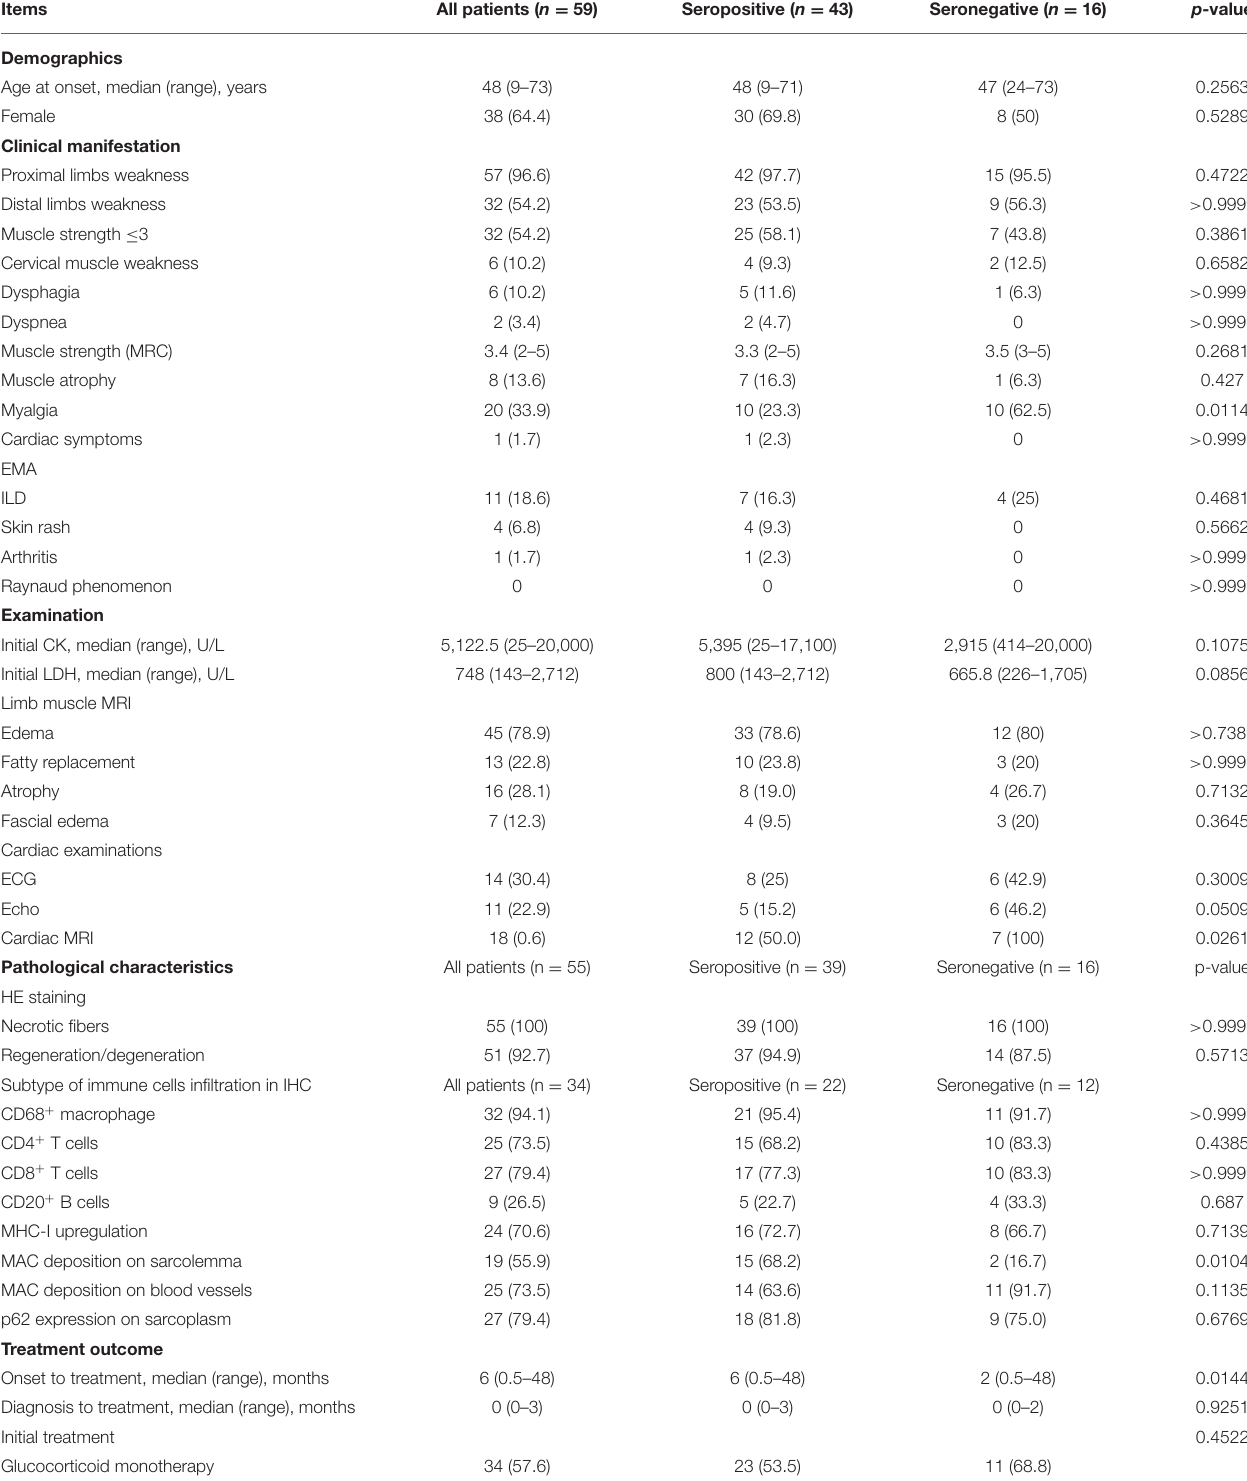
TABLE 2 | Comparison between patients with seropositive and seronegative